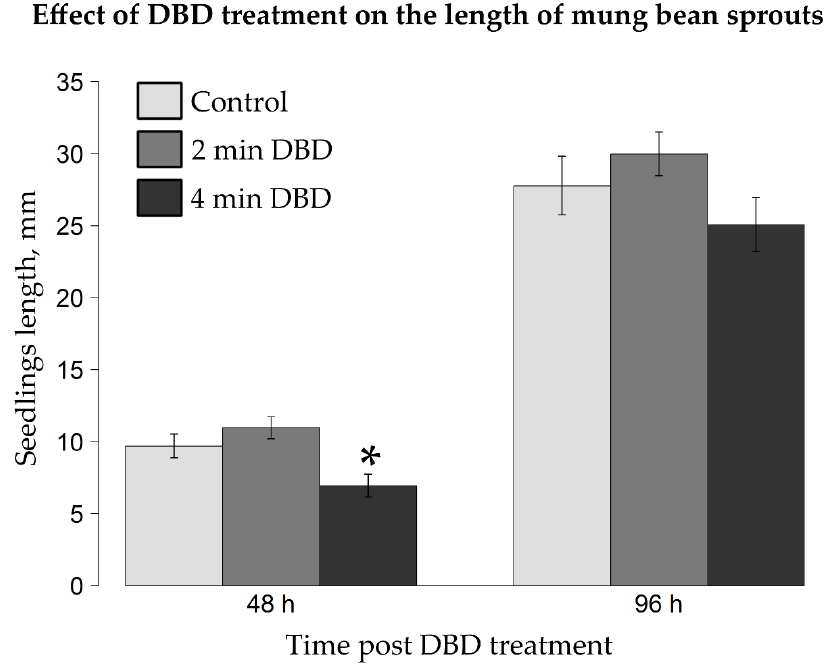
Figure 4. Effect of the NTAPP treatment on the length of mung bean sprouts. The seeds had been exposed to DBD, being the NTAPP source, for 0, 2, or 4 min. The resultant seedlings were measured after 48 h and 96 h of incubation. Bars depict means ± standard errors. Asterisk marks a statistically significant difference in comparison to the untreated control sample (Welch’s t -test at p < 0.05).